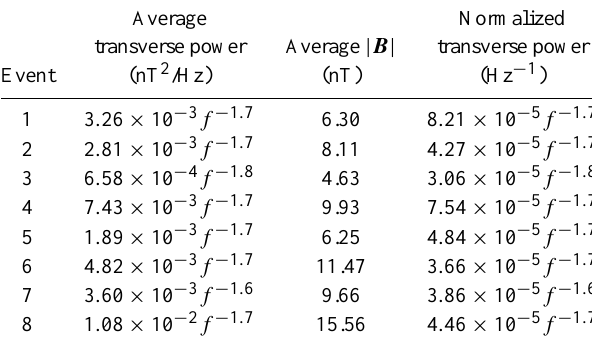
Table 2. Transverse power spectra for 8 scatter-free events Average Normalized transverse power Average | B | transverse power